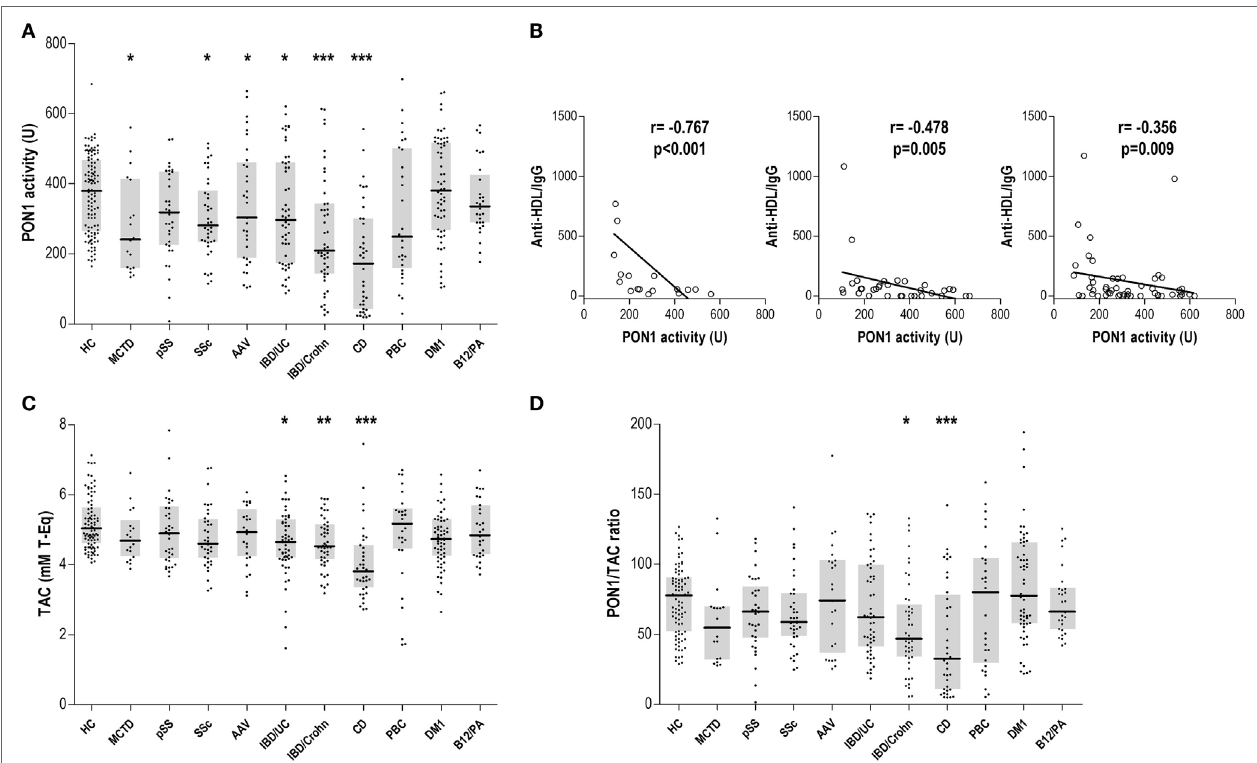
FigUre 2 | Paraoxonase 1 (PON1) activity, total antioxidant capacity (TAC), and PON1/TAC ratio in autoimmune conditions. (a) Serum PON1 activity, (c) serum TAC, and (D) PON1/TAC ratio were evaluated in autoimmune patients and healthy control (HC). Each dot represents one subject, whereas horizontal bar represents the median value and gray boxes delimit 25th and 75th percentiles. Differences against HC group were assessed by Kruskal–Wallis test and Dunnett correction for multiple comparisons test. Statistical significance is indicated as * p < 0.05, ** p < 0.010, and *** p < 0.001. (b) Association between anti-high-density lipoprotein/IgG and serum PON1 activity in mixed connective tissue disease (MCTD), ANCA-associated vasculitis (AAV), and IBD/UC patients. Correlations were assessed by Spearman rank’s